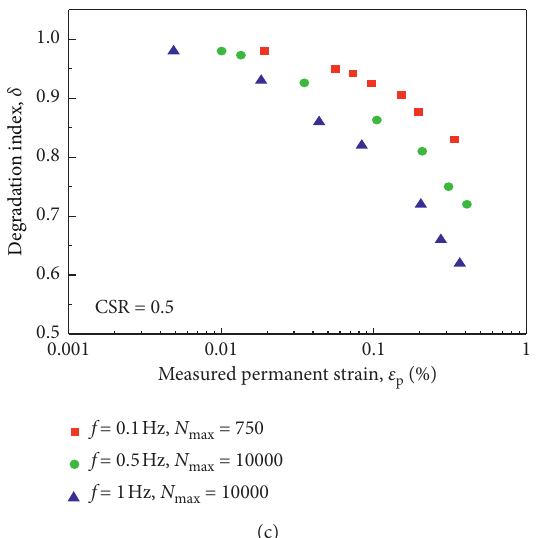
Figure 13: Relationship of f and δ versus ε p under different cyclic stress ratios (CSR): (a) CSR